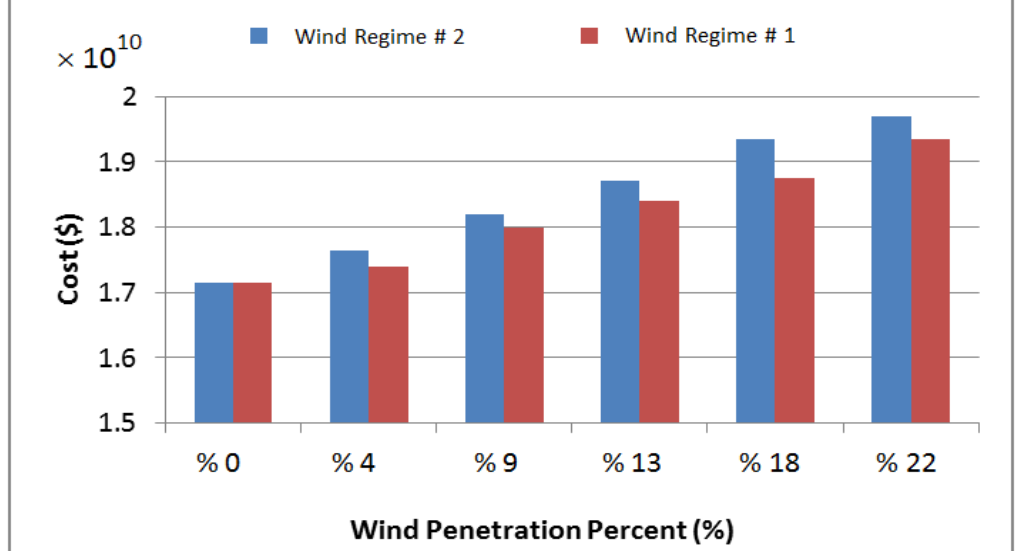
Figure 3. Increasing the cost of wind penetration plans in the system.